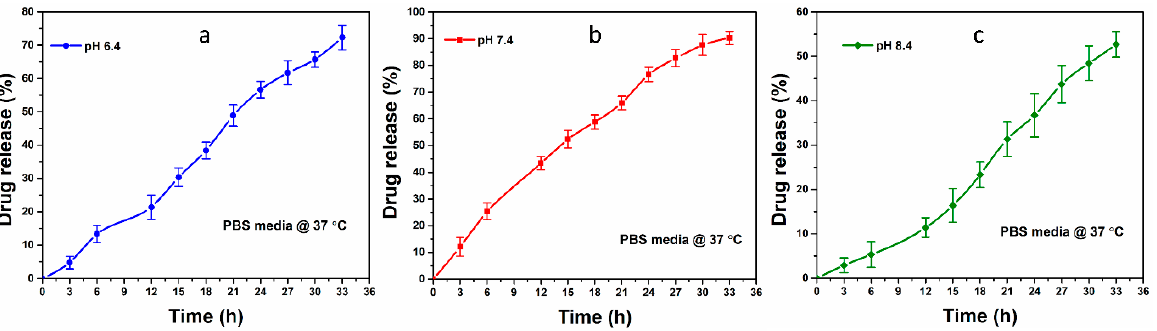
Figure 5. The drug release of curcumin was studied at 37 °C under different pH levels to determine the release analysis behavior: ( a ) Curcumin release at pH 6.4; ( b ) Curcumin release at pH 7.4 and; ( c ) Curcumin release at pH 6.4.